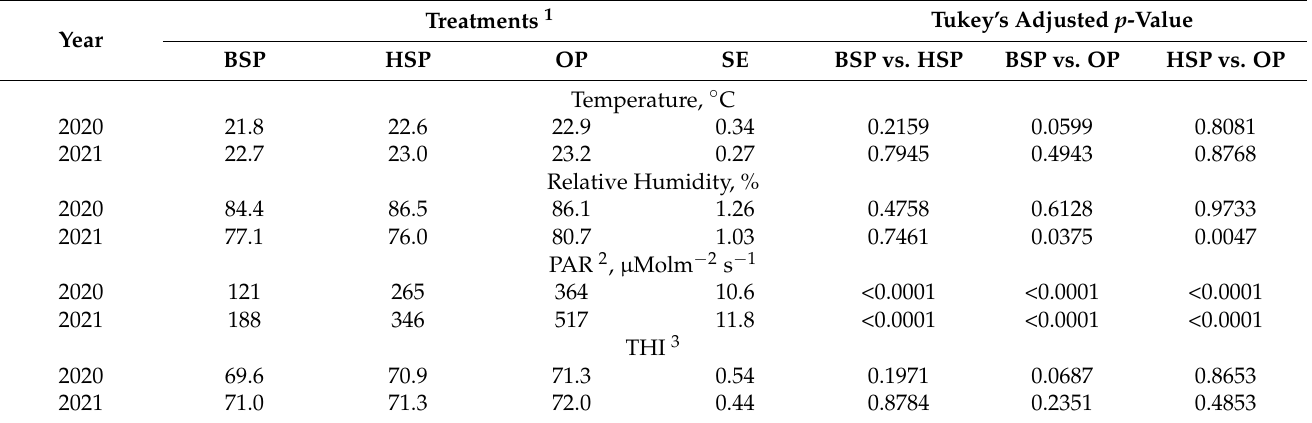
Table 2. Microclimatic conditions in an open pasture (OP), black walnut silvopasture (BSP), and honeylocust silvopasture (HSP) treatments throughout the study period during the summers of 2020 and 2021 at the Whitethorne Agroforestry Demonstration Center, Blacksburg, VA,